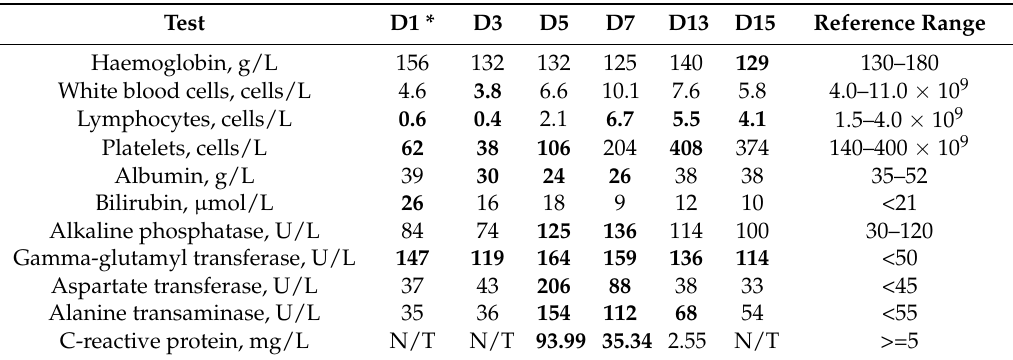
Table 1. Laboratory test results, showing thrombocytopenia and transaminitis that persisted for several days